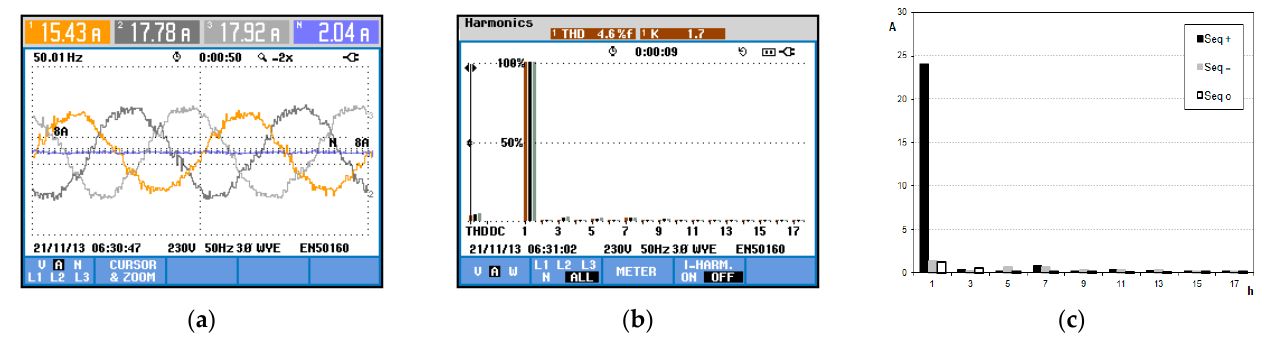
Figure 34. Case 3 - four-wire ShAPF operating with balanced loads: ( a ) three-phase currents; ( b ) harmonic spectrum of the currents; ( c ) harmonic spectrum of the current sequence components (maximum values).